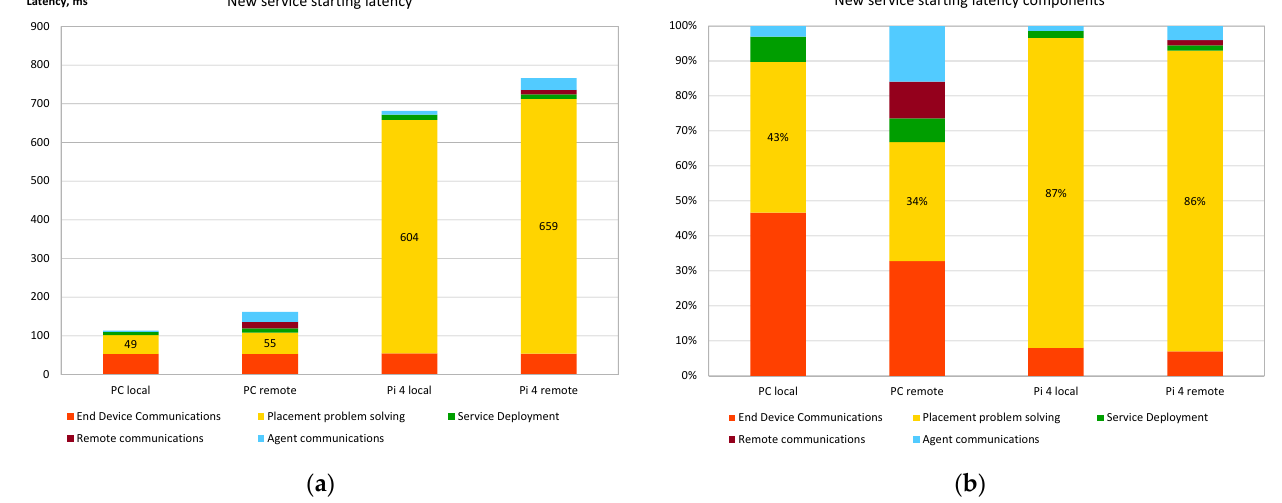
Figure 10 . Evaluation of the latency of the new service starting: ( a ) Absolute latency; ( b ) Relative latency caused by different parts of the placement algorithm.